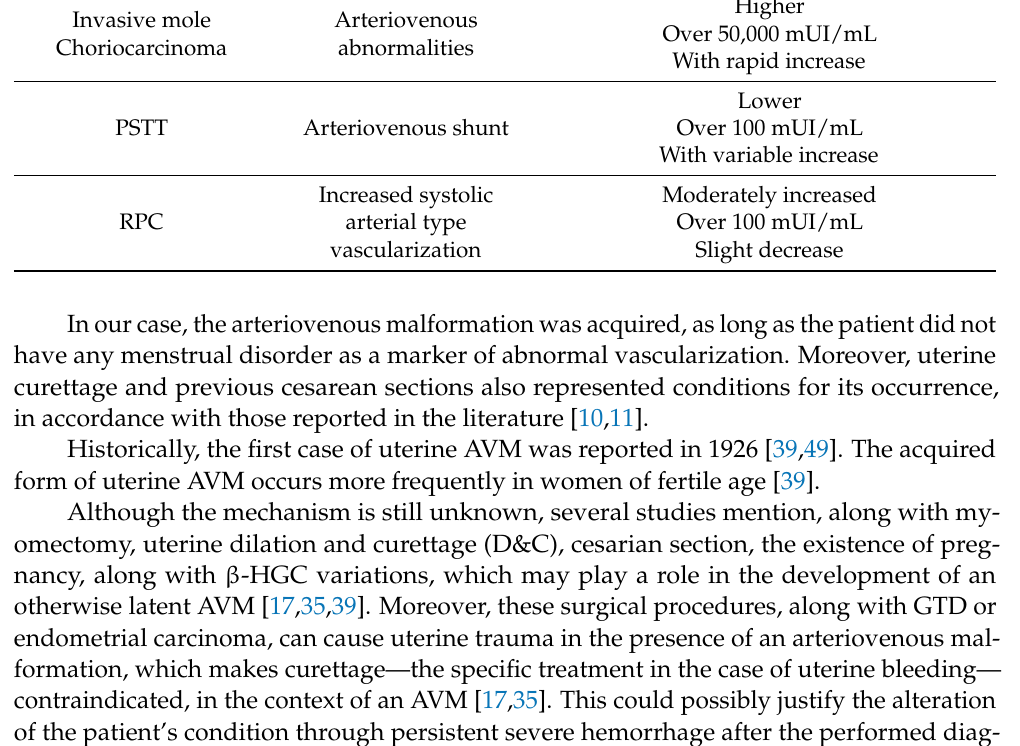
Table 2. Differential diagnosis of arteriovenous malformation, according to β -HGC dynamics. Differential Characteristic Diagnosis Ultrasound Features Invasive mole